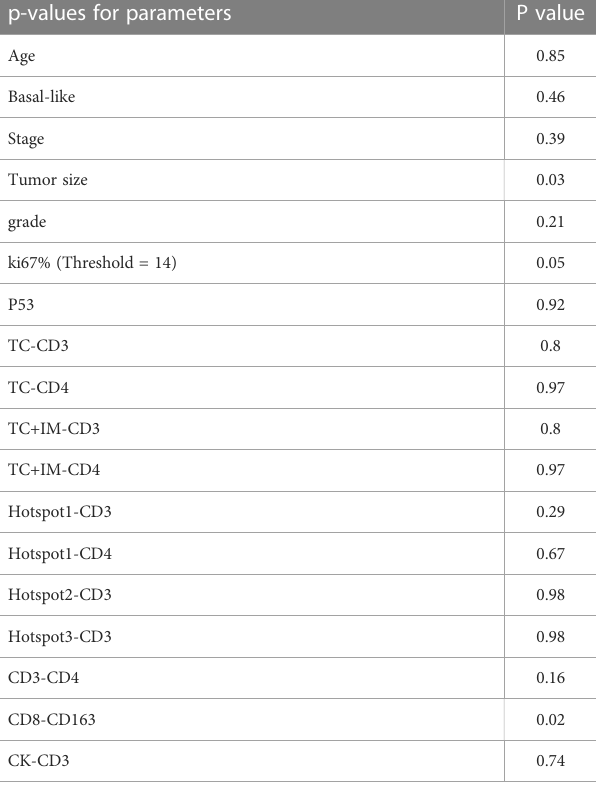
TABLE 6 The multivariate survival analysis with OS of all parameters based on cell positive density for the group of all patients. p-values for